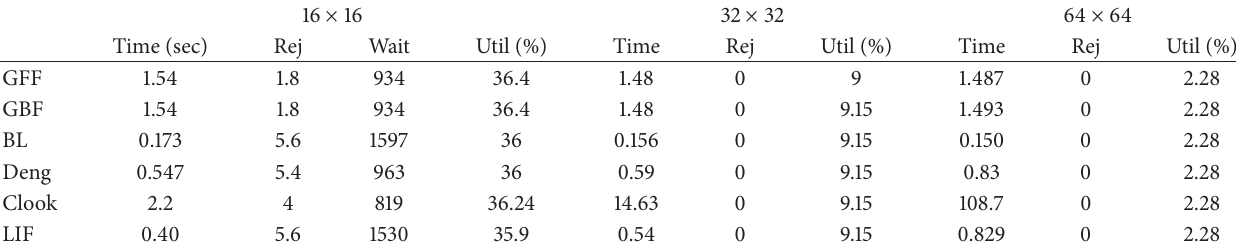
Table 1: Utilization factor average waiting time and execution time.